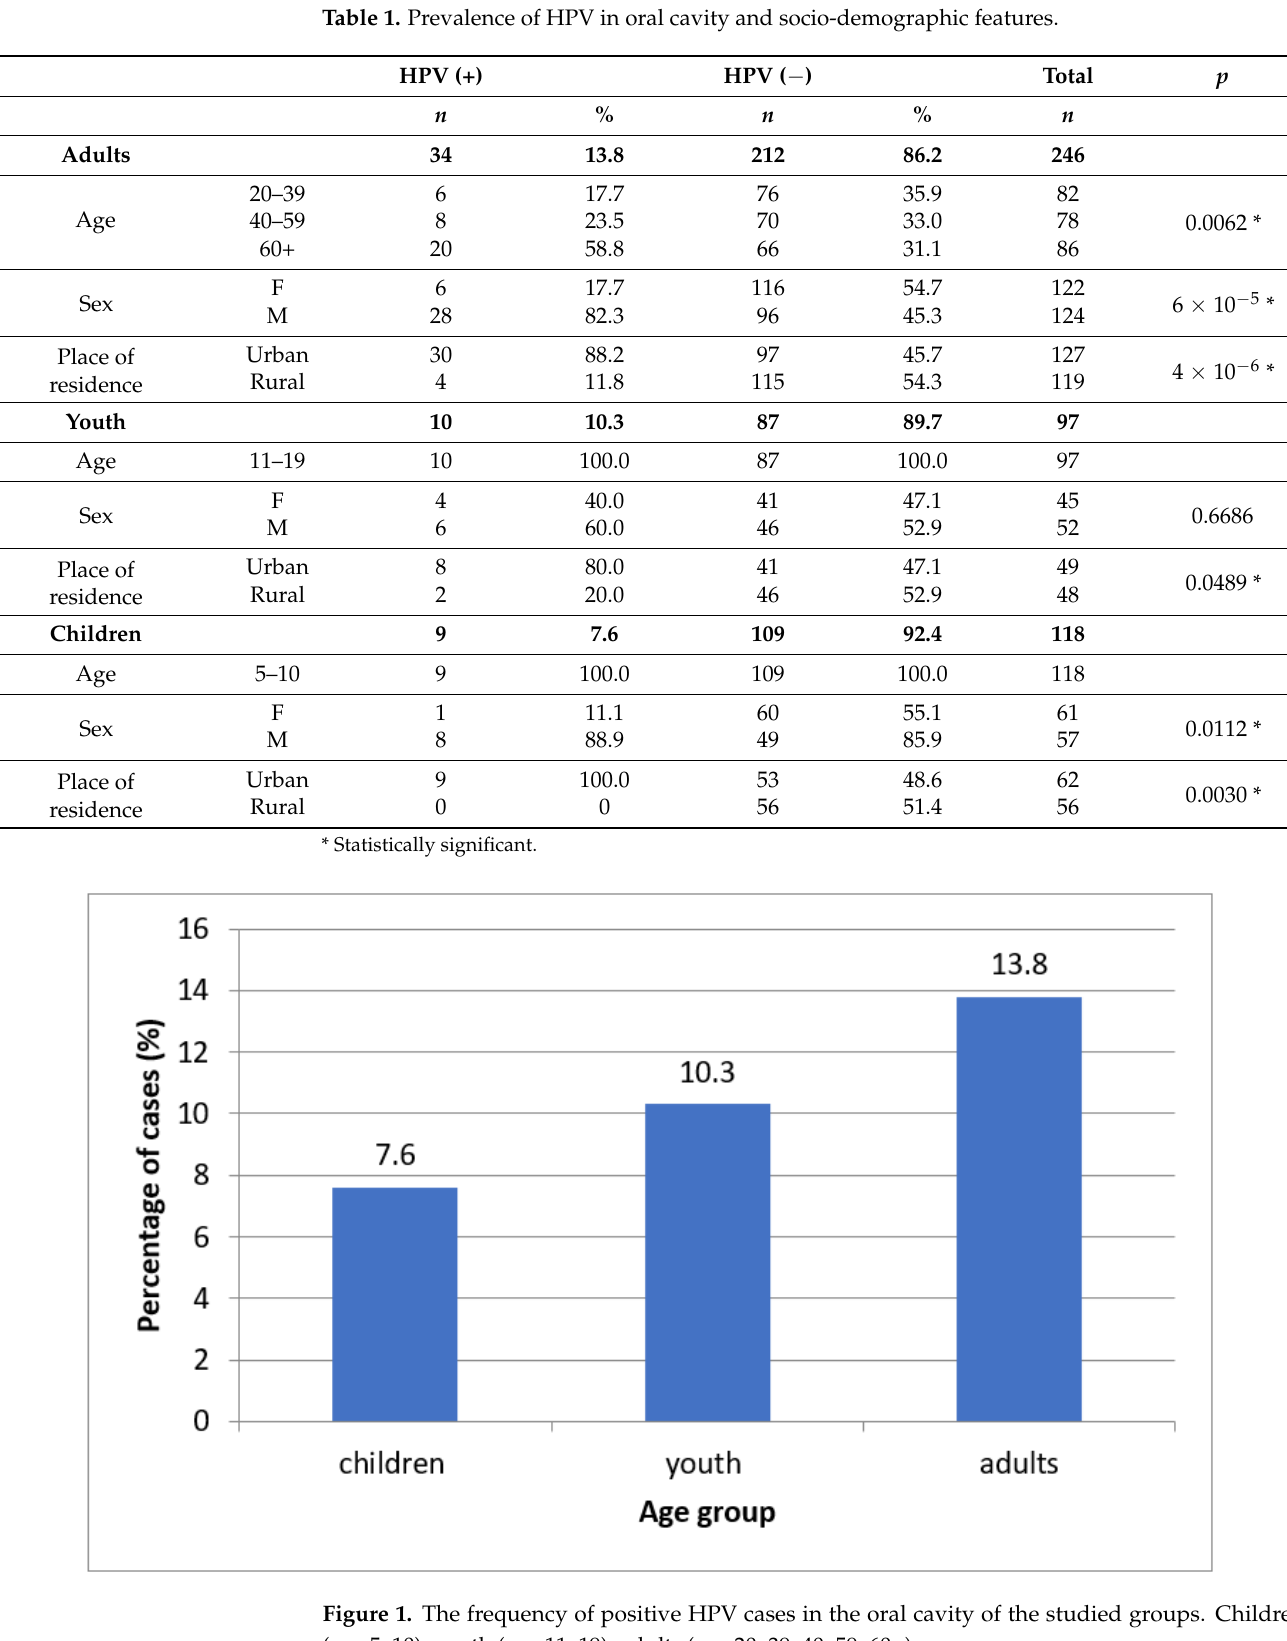
Table 1. Prevalence of HPV in oral cavity and socio-demographic features.